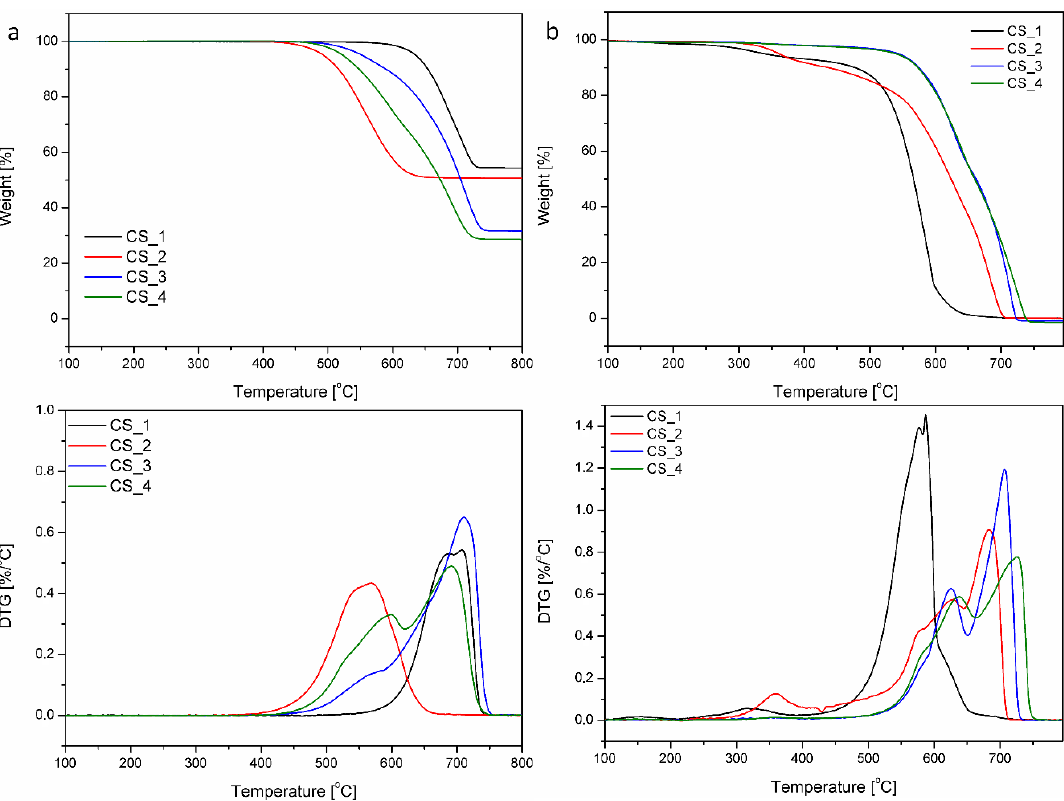
Figure 6. Thermogravimetry analysis (TGA) and differential thermogravimetry (DTG) curves of carbon spheres with different times of synthesis. Before ( a ) and after ( b ) removing silica